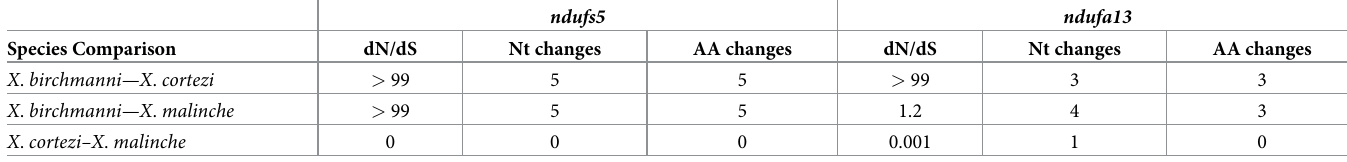
Fig 4. Evidence for repeated hybrid incompatibilities between X . birchmanni × X . malinche and X . birchmanni × X . cortezi hybrids. A . Interacting locus of the shared chromosome 6 ancestry desert identified in a genome-wide scan. This region was identified scanning for deviations from expected two locus genotypes using a χ 2 test in F 2 hybrids, based on observed genotypes at the shared chromosome 6 desert and genotypes at other loci throughout the genome. Genome-wide significance threshold (FPR 5%; blue line) was determined using permutations, see Methods for details. Inset shows STRING network with experimentally verified interactions between ndufa13 (contained in the chromosome 6 region) and ndufs5 (contained in the chromosome 13 region). B . Ratio of expected to observed two-locus genotype combinations in F 2 hybrids between X . birchmanni × X . malinche at the shared chromosome 6 desert and associated chromosome 13 region. Capital letters indicate genotype at chromosome 6 and lowercase letters indicate genotype at the chromosome 13 region. For visualization, certain genotype combinations are collapsed (i.e. homozygous parental–BBbb & MMmm; heterozygous locus 1, homozygous locus 2 –MBbb & MBmm). Note that several genotype combinations were expected to be found at low frequency due to low X . birchmanni ancestry on chromosome 13 (MMbb, MBbb, BBbb). C. A second interaction between the minor parent desert on chromosome 9 and a region on chromosome 4 is detected at a relaxed FPR of 10%. D . This minor parent desert is shared between X . birchmanni × X . cortezi hybrid populations and the Acuapa X . birchmanni × X . malinche hybrid population and occurs on chromosome 9 at 12.1 Mb. Points represent minor parent ancestry calculated in 10 kb non-overlapping windows divided by the proportion of the genome derived from the minor parent species. Red–Tlatemaco ( malinche × birchmanni ), Blue–Acuapa and Aguazarca ( birchmanni × malinche ), Green–Santa Cruz ( birchmanni × cortezi ). https://doi.org/10.1371/journal.pgen.1009914.g004 high expression network centrality compared to matched null datasets. We did not find clear evidence that the interaction networks of genes in minor parent deserts (or islands) deviated from the genome-wide background (Text J in S1 File). Table 1. Nucleotide (Nt) and amino acid (AA) changes between species pairs in interacting genes between the chromosome 6 and chromosome 13 regions. Ratios of rates of nonsynonymous to synonymous substitutions (dN/dS) inferred by codeml [60] are also shown. Comparisons where dN/dS is marked as > 99 are due to all nucleo- tide changes being